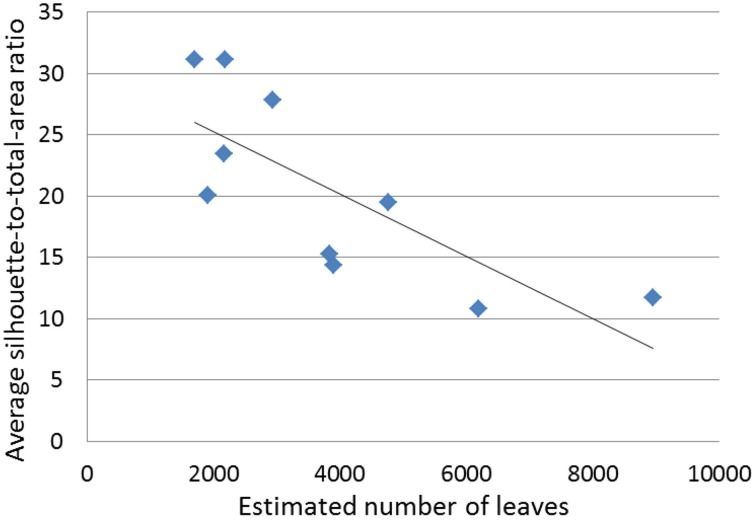
Average silhouette-to-total-area ratio (STAR) against estimated number of leaves (N) for the 10 miniature conifers with needlelike leaves.